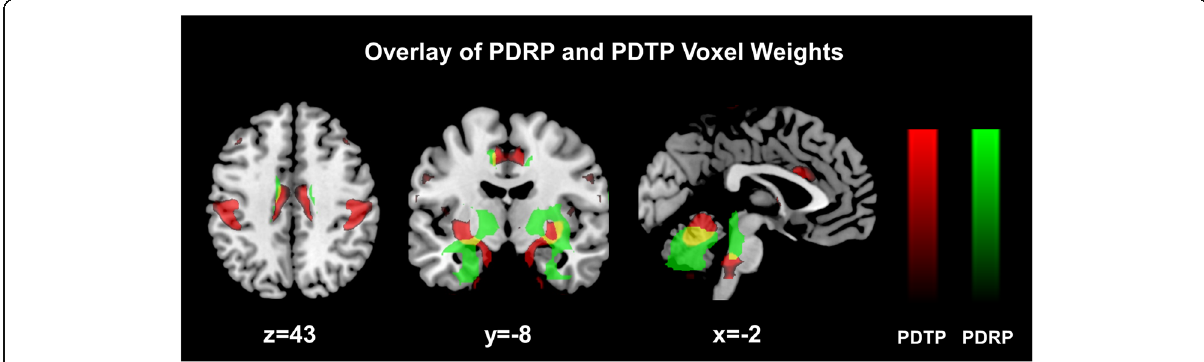
Fig. 2 Comparison of PDRP and PDTP topographies. Display of brain areas contributing to PDRP ( green ) and PDTP ( red ) metabolic networks along with areas of overlap ( yellow ) primarily in cerebellum, pons and putamen. The images for both patterns were overlaid on a standard MRI brain template and share 18% of variance between all non-zero voxel weights. [Reprinted from Neuroimage 54:1244 – 1253. Mure H, Hirano S, Tang CC, Isaias IU, Antonini A, Ma Y, Dhawan V, Eidelberg D. Parkinson ’ s disease tremor-related metabolic network: characterization, progression, and treatment effects. Copyright (2011), with permission from